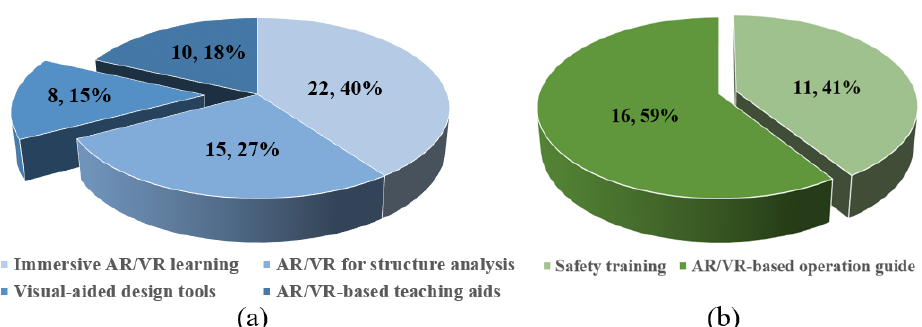
Figure 10. ( a ) The percentage of AR/VR applications in education. ( b ) The percentage of AR/VR applications in training.